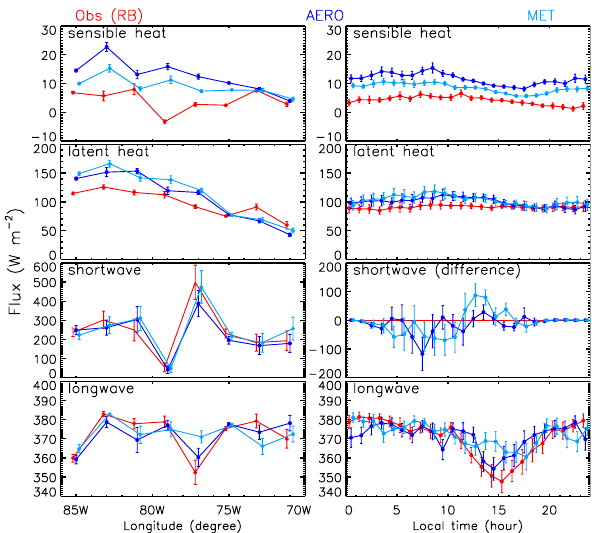
Fig. 11. Longitudinal and diurnal variations of surface fluxes in- cluding sensible heat, latent heat, downward shortwave, and down- ward longwave fluxes, from the sonic anemometer observations on the RB (red) and from the AERO (blue) and MET (light blue) simu- lations. The diurnal cycle of incoming shortwave fluxes is plotted as the difference between modeled and observed values. The vertical bars indicate ± 2 σ , where σ is the standard deviation of the mean p value given by σ = var (x i )/n , where var( x i ) is the variance of data used for the averaging, and n is the number of the data points. Note that due to the large variability in some parameters, σ is not represented as the square root of the variance as in other